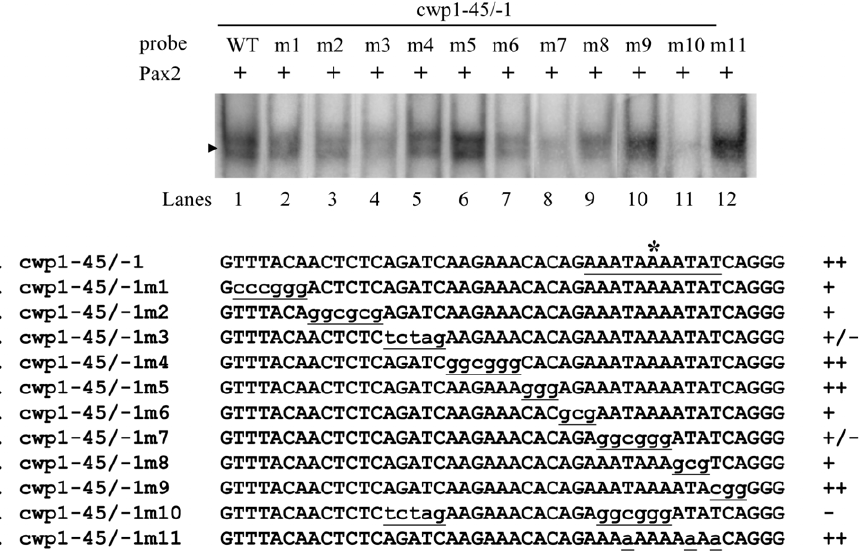
Figure 5. Mutation analysis of the cwp1-45/ 2 1 probe sequence containing the putative Pax2 binding site. Electrophoretic mobility shift assays were performed using purified Pax2 and various 32 P end-labeled cwp1-45/ 2 1 mutant probes as described. Base changes in the mutants are shown in underlined lowercase type. Components in the binding reaction mixtures are indicated above the lanes. The arrowhead indicates the shifted complex. The transcription start site of the cwp1 gene determined from 24-h encysting cells is indicated by an asterisk [13]. The AT-rich Inr element spanning the transcription start site is underlined. ‘‘ + ’’, ‘‘ + / 2 ’’, and ‘‘ 2 ’’ represent moderate binding, weak binding, and no binding, respectively. ‘‘ +++ ’’ and ‘‘ ++ ’’ represent strong binding.